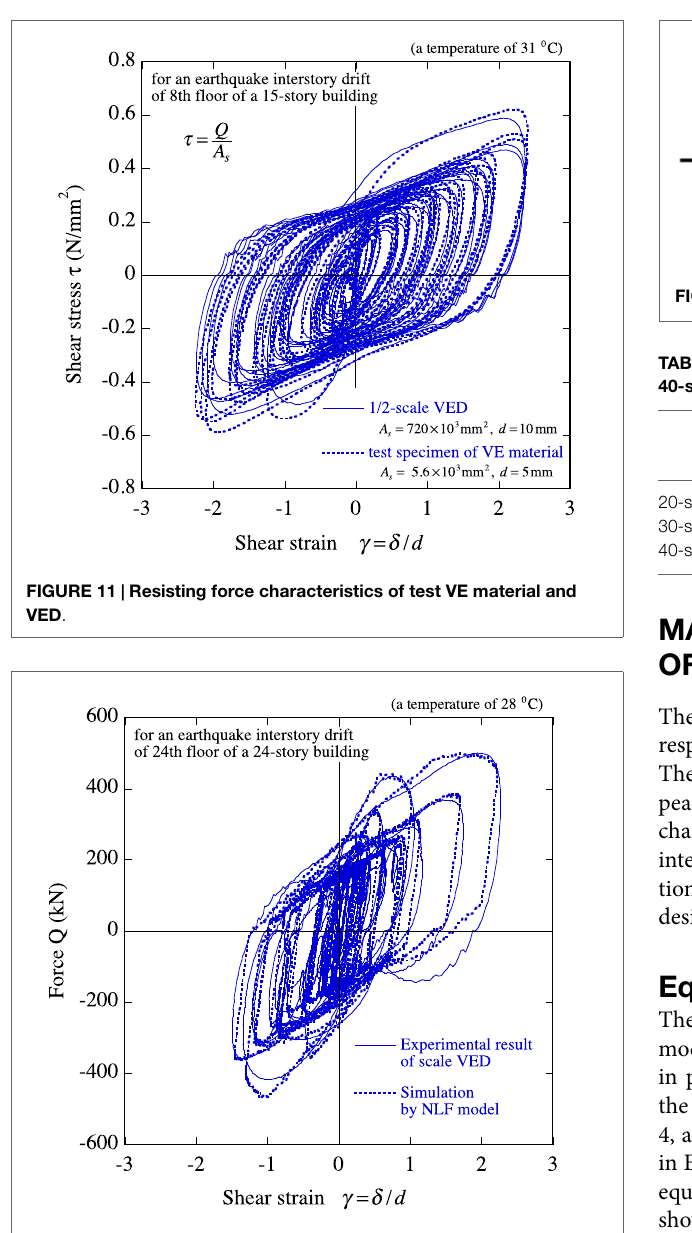
FIGURE 12 | Resisting force characteristics of mechanical model and experimental results of VED .